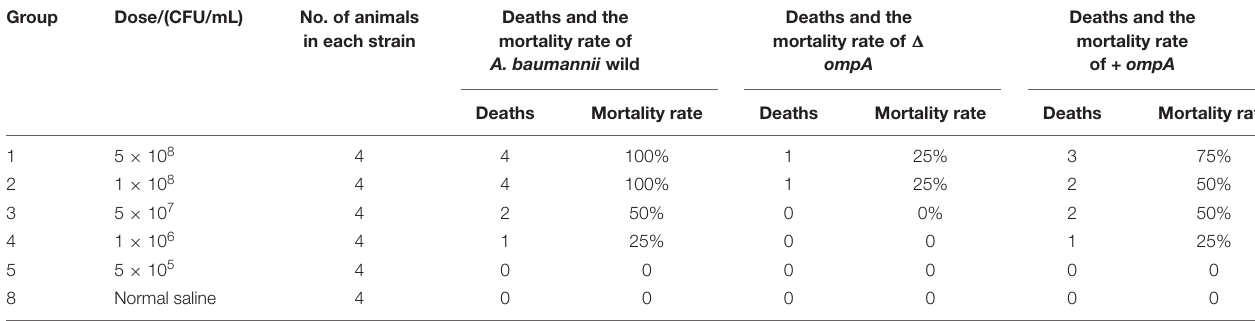
TABLE 1 | The pathogenicity of A. baumannii wild, (cid:49) ompA, and + ompA strain in mice. Group Dose/(CFU/mL) No. of animals